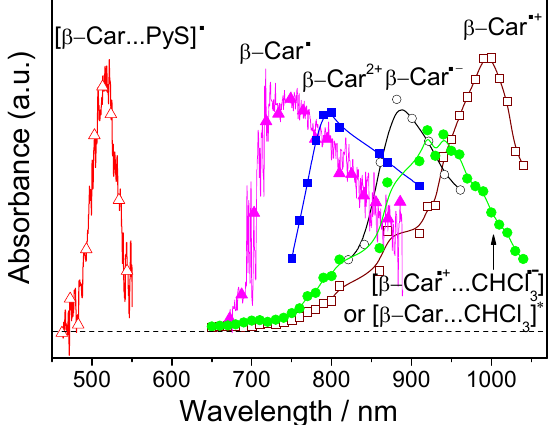
Figure 1. Absorption spectra of β -carotene ( β -Car) oxidized or reduced radicals ( from left to right ) including adduct radical ([ β -Car ··· PyS]  , ∆ ) [37], neutral radical ( β -Car  , ▲ )